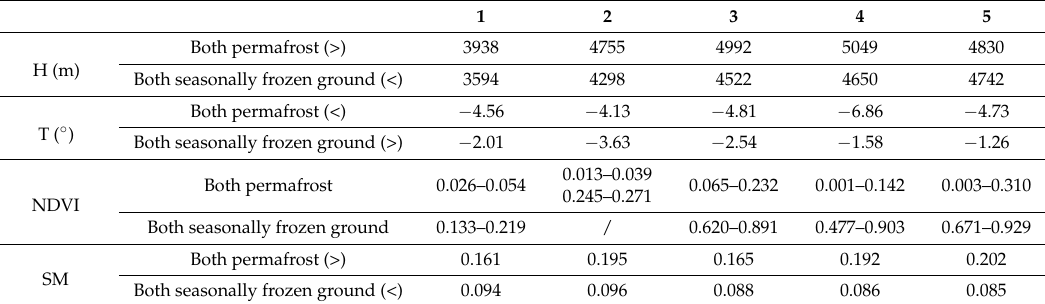
Table 1. Classification threshold of every index for five latitude zones.